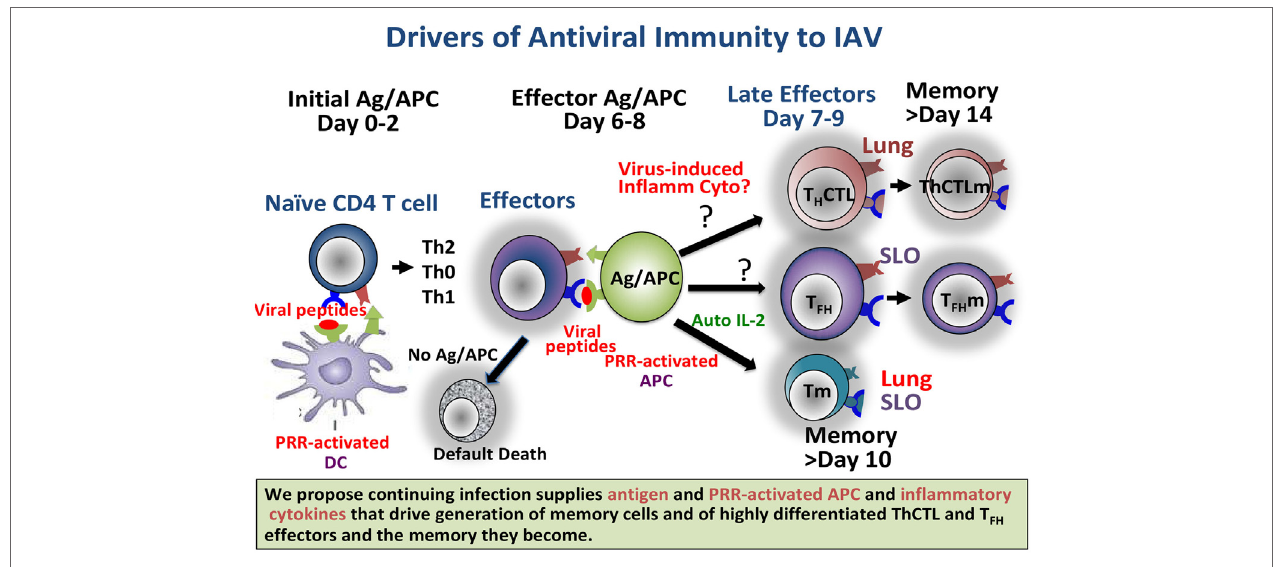
FIGURE 1 | Continuing infection, producing abundant antigen and pattern recognition receptor (PRR)-activated APC, and we propose inflammatory cytokines, drives generation of memory cells and of highly differentiated ThCTL and T FH effectors and the memory they become. Providing such signals in a vaccine setting should result in longer-lasting more protective immunity. Known and likely roles for viral Ag and for PRR in the response to Influenza A virus are